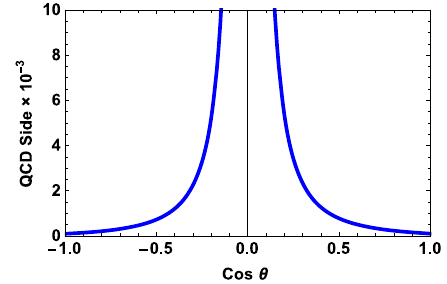
Fig. 1 The variation of the QCD side (in units of GeV 6 ) for the 2 P excitation of (cid:2) c baryon as a function of cos